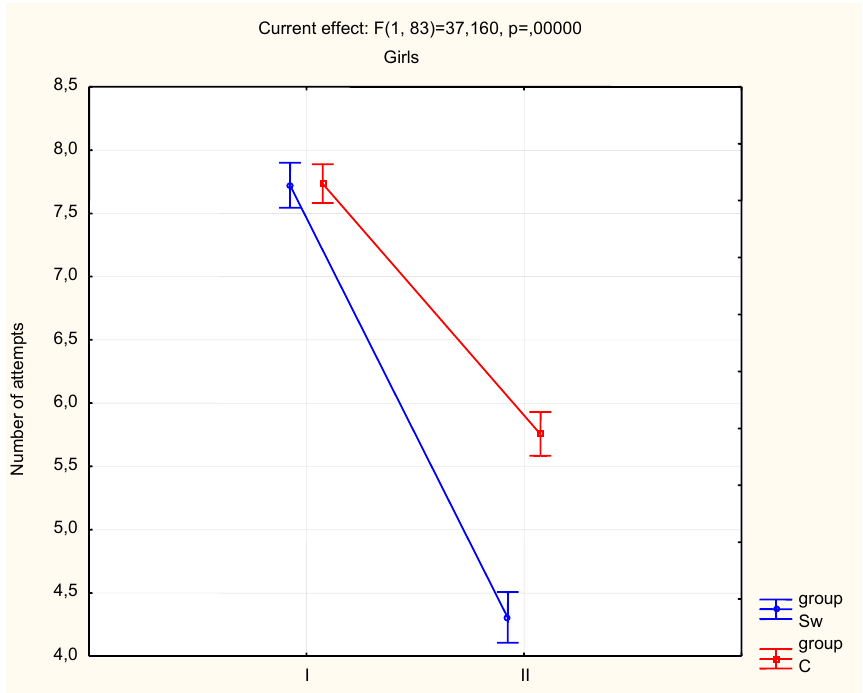
Fig 1. Changes of Flamingo Balance Test (general balance) results in Swimmers (Sw) and Control groups